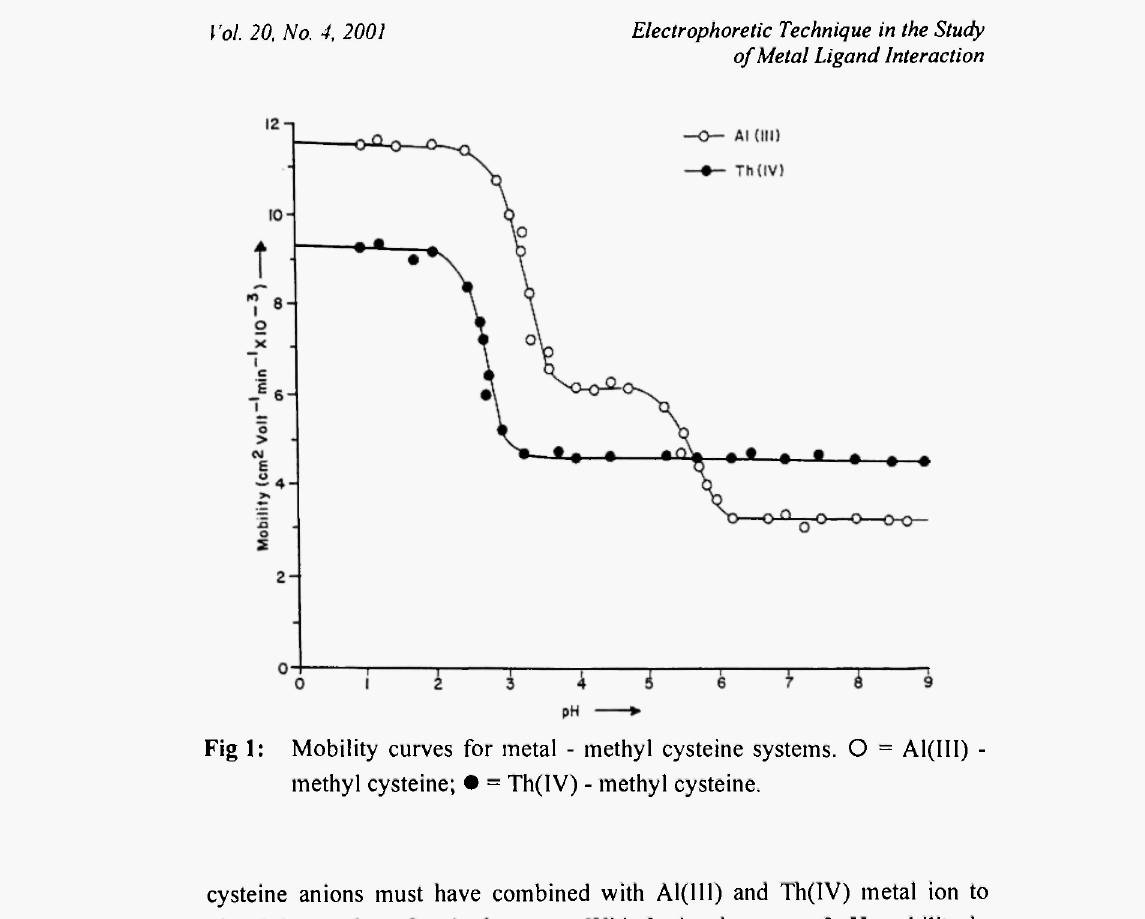
Fig 1: Mobility curves for metal - methyl cysteine systems. Ο = Al(III) - methyl cysteine; · = Th(IV) - methyl